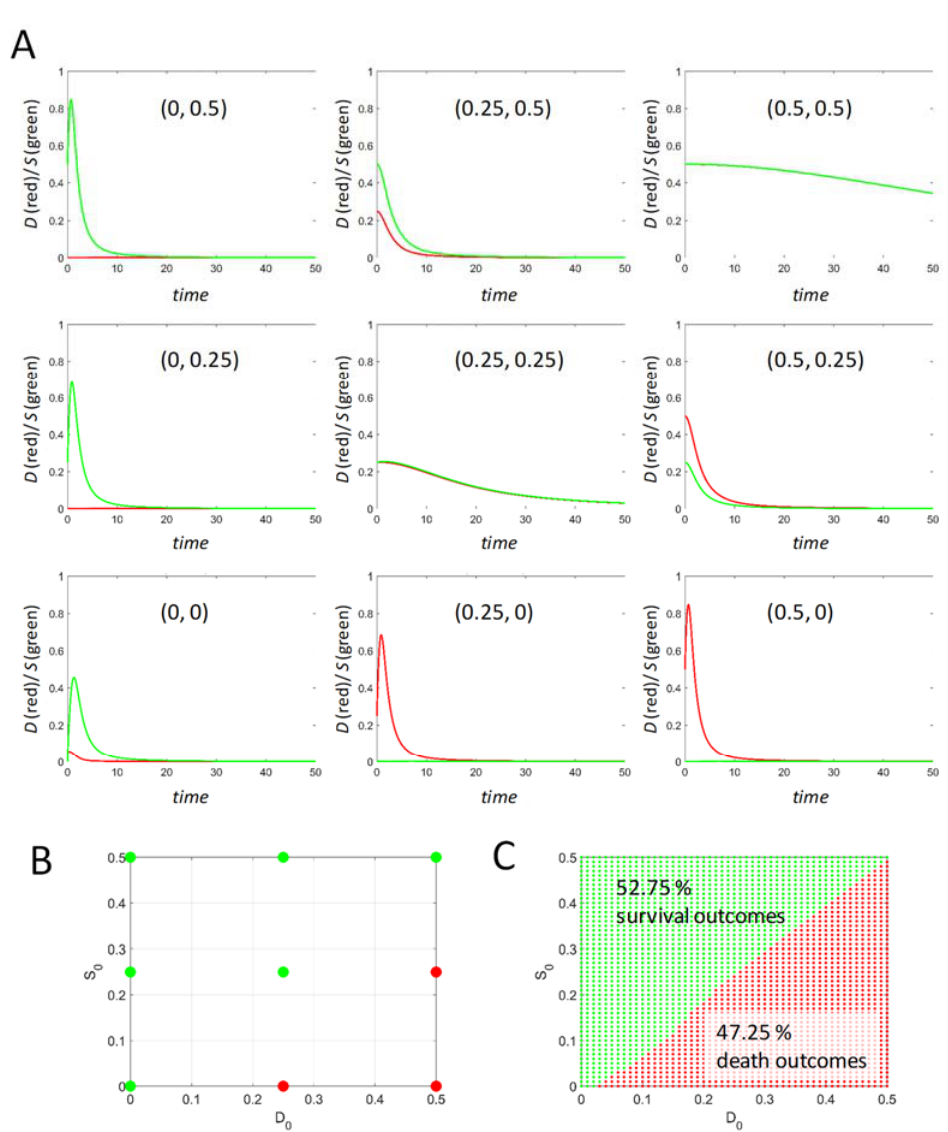
Figure 3 : Time courses at I = 0.43 < I X , from varying initial conditions. ( A ) A series of nine D and S time courses started from initial conditions ( D 0 , S 0 ) as listed on each plot. ( B ) The plane of initial conditions used for the time courses in A, where the outcomes are indicated by green (survival) or red (death) dots. ( C ) The same plane in B filled in with 2500 time course outcomes demarcating a survival and a death region with respect to initial conditions.